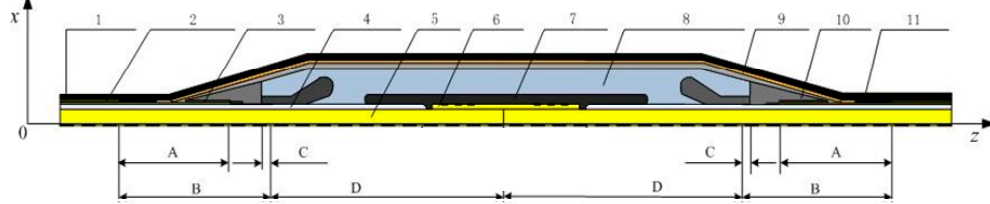
Figure 1. Axial cross-section model of cable joint.